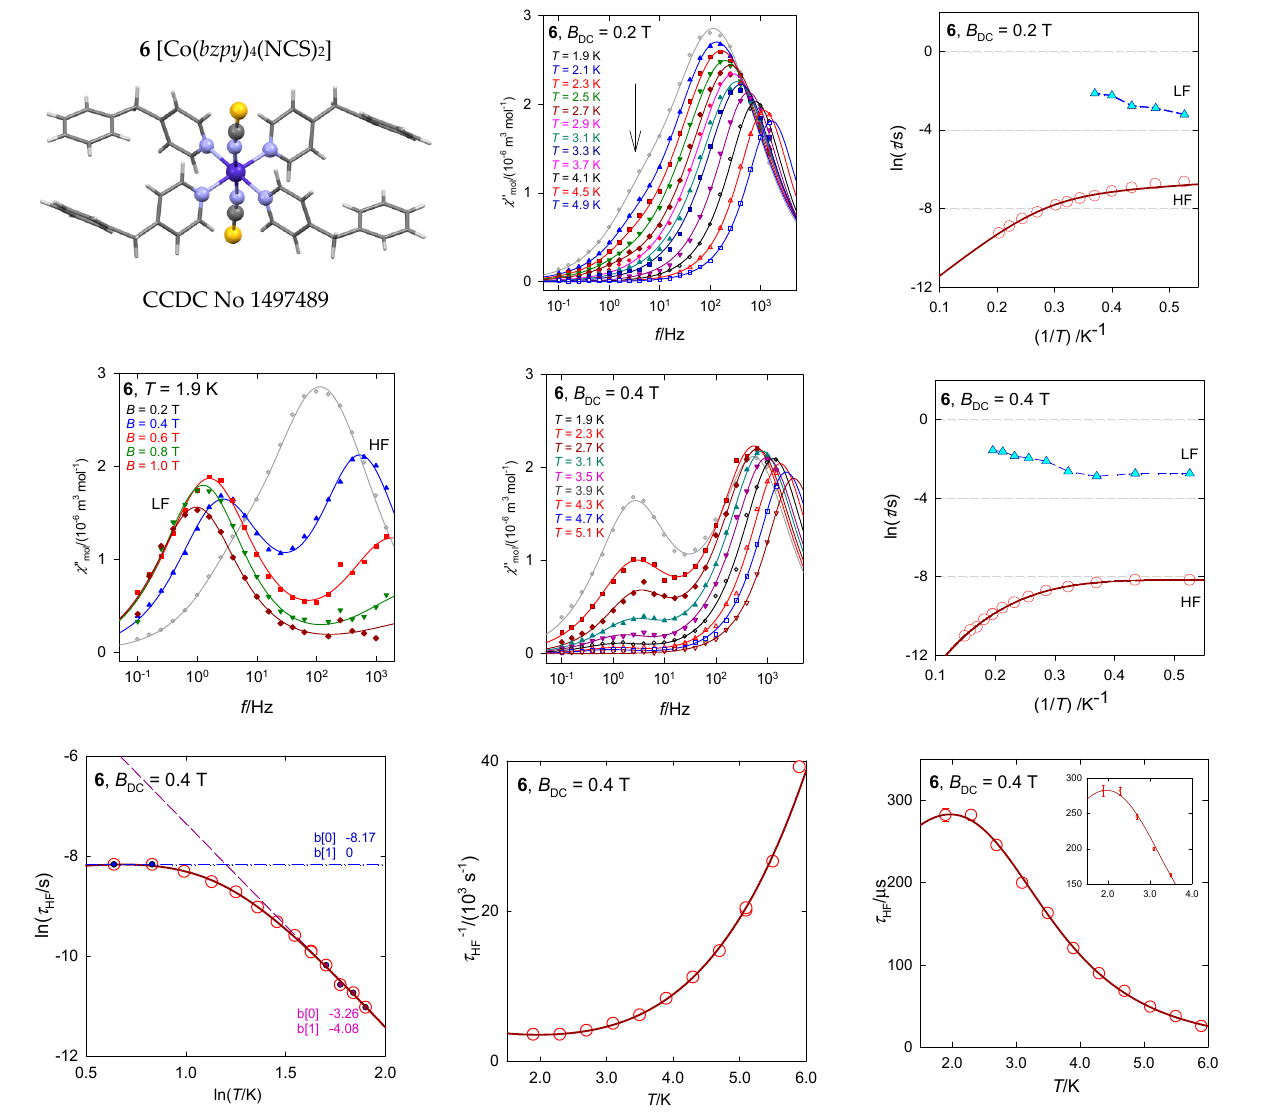
Figure 14. AC susceptibility data for 6 . Full lines—fitted. Data adapted from ref. [34]. 2017, Wiley-VCH. The dinuclear complex [Co III Co II (LH 2 ) 2 (CH 3 COO)(H 2 O)](H 2 O) 3 , 7 , contains the mag- − 1 . The magnetic anisotropy is of the easy-axis ∆ − 711 cm − 1 , ∆ ax / hc = rh / hc = 44 cm